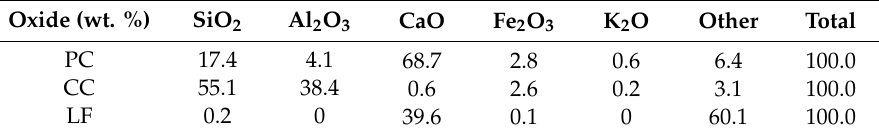
Table 1. The chemical composition of the dry components in the mix